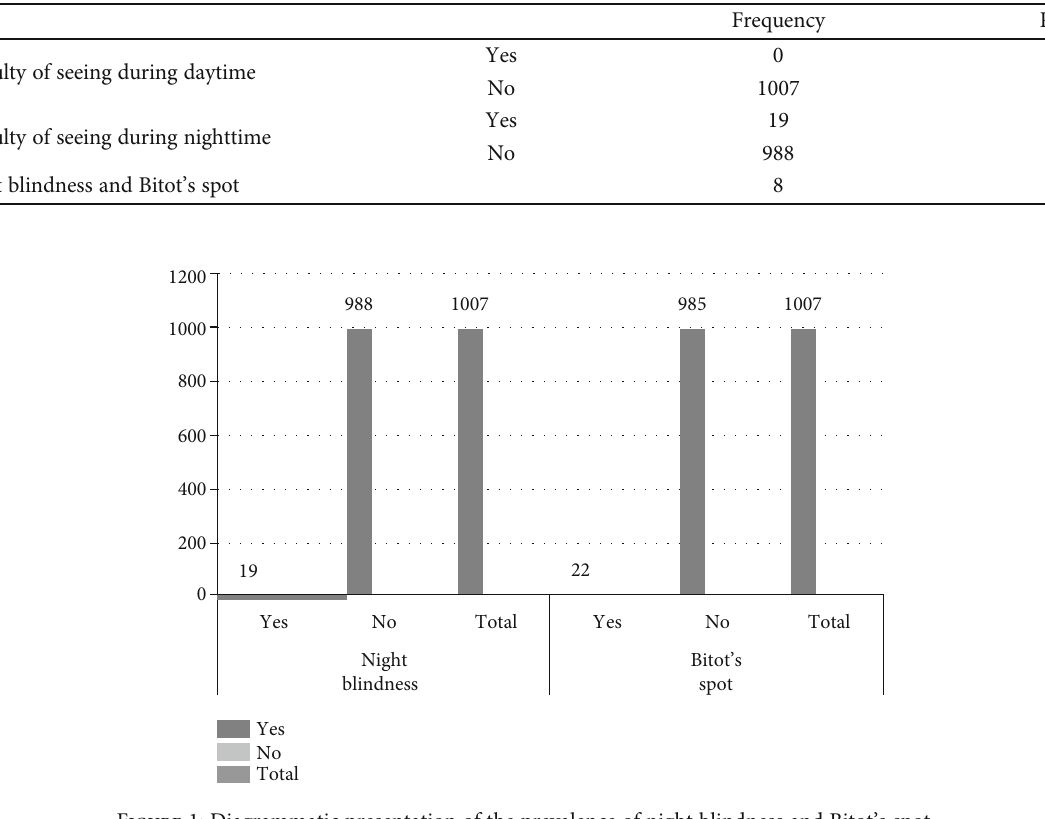
Figure 1: Diagrammatic presentation of the prevalence of night blindness and Bitot ’ s